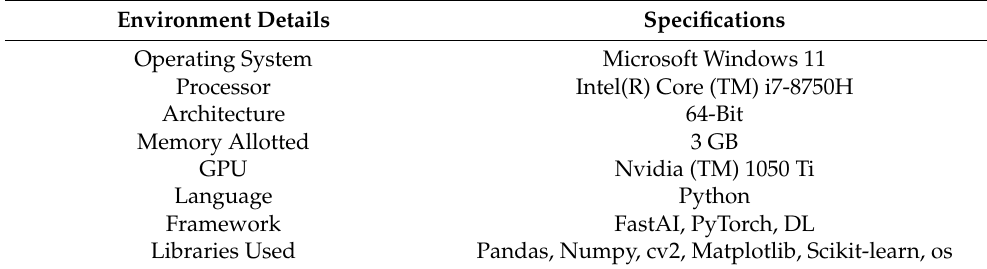
Table 5. Details of Implementation